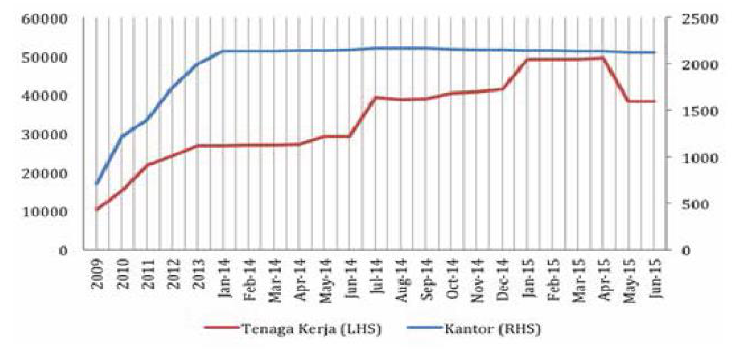
Figure 1 Labor and Network of Sharia Banking offices